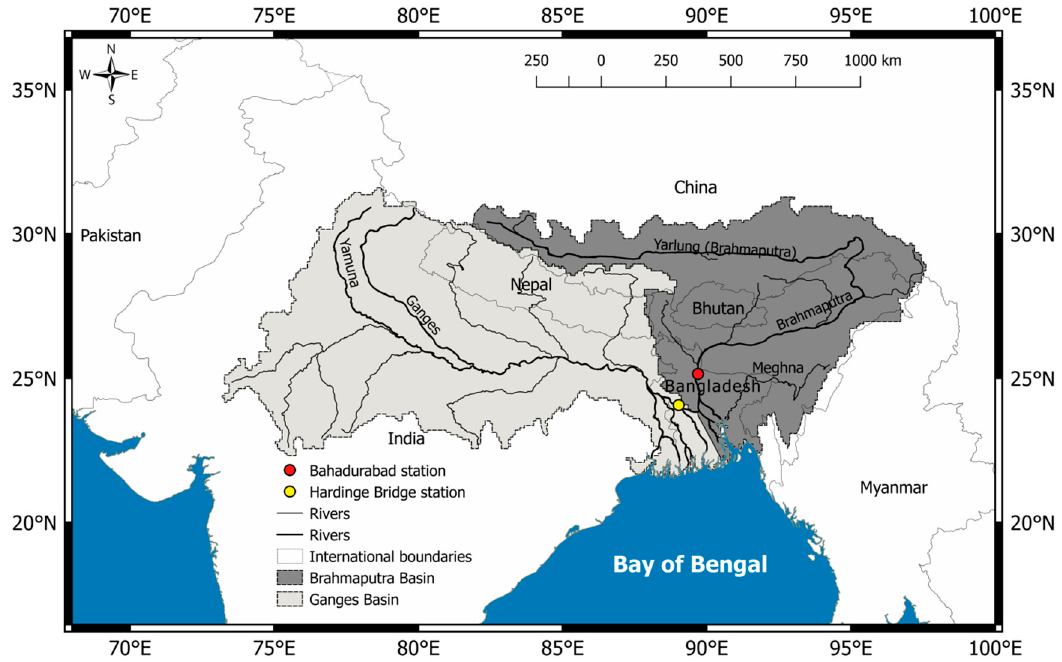
Figure 1. Ganges and Brahmaputra River basin, with the respective catchment areas shown in light gray (Ganges) and dark gray (Brahmaputra). The black lines show the main rivers (thick line) and associated tributaries (thin line) hydrography. Political borders are shown in a gray line. The red and the yellow circles correspond to the locations of Bahadurabad and Hardinge Bridge in situ gauging stations respectively where altimeter-derived river discharges are estimated.